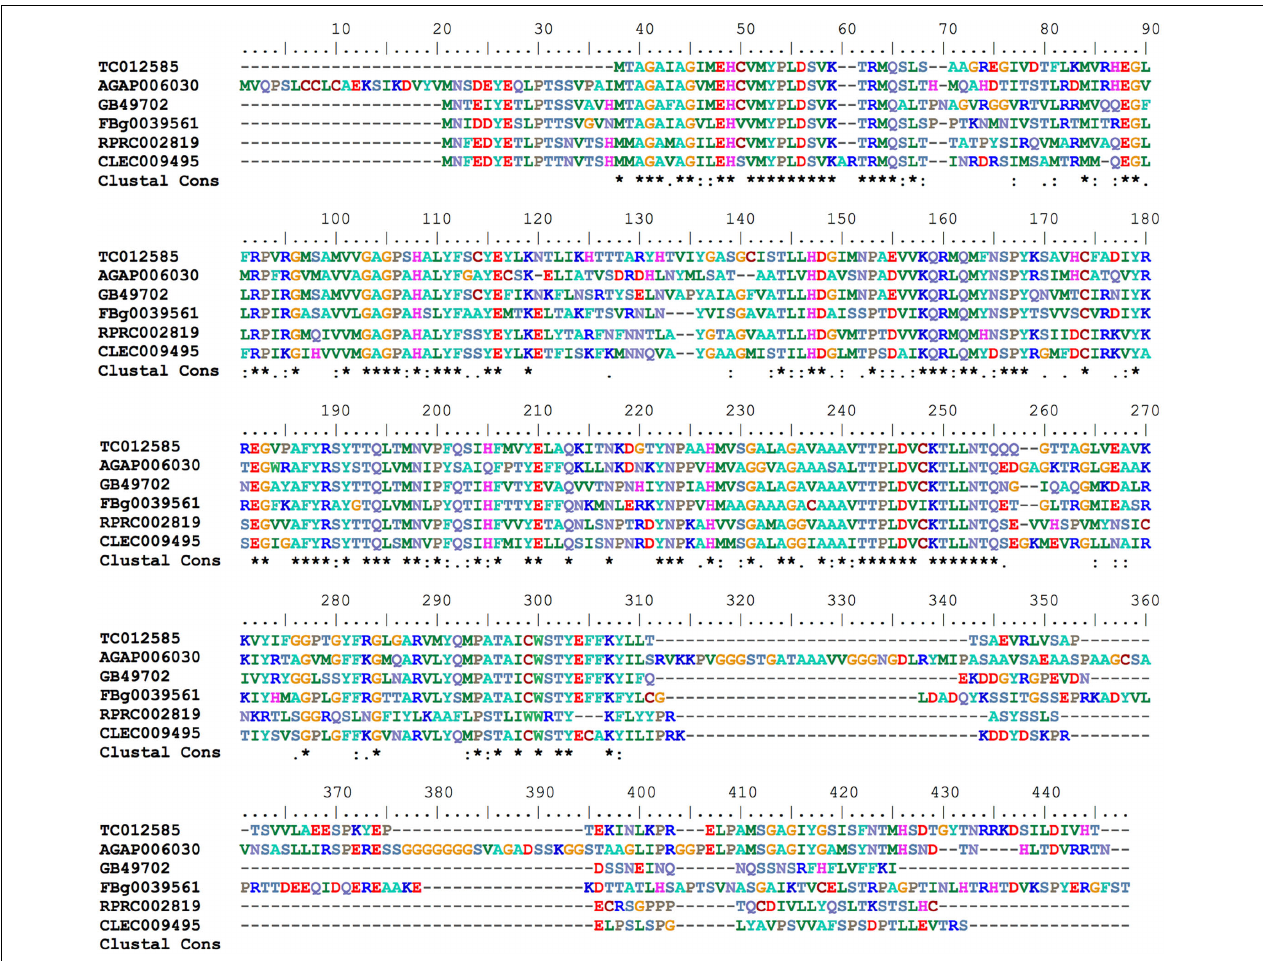
FIGURE 7 | Multiple amino acid sequence alignment of R. prolixus mitoferrin predicted amino acid sequences with insect orthologs. Amino acid color code generated by ClustalW within BioEdit software was used. Consensus residues (“Clustal cons” line) were generated by